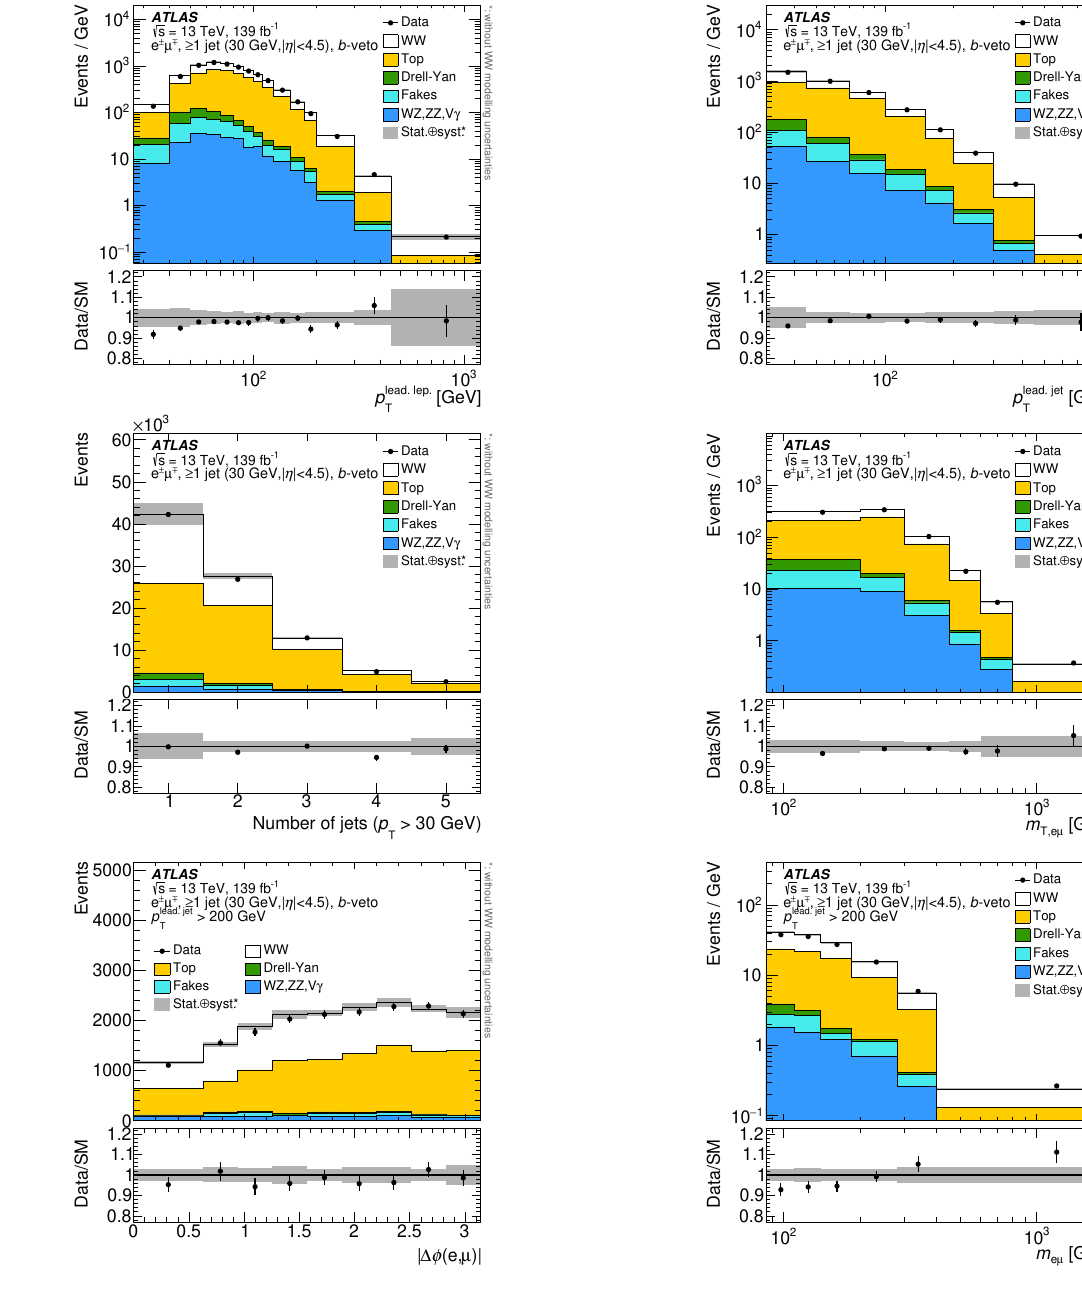
(top left), the p lead. jet (top T T (middle right), and, for events with p lead. jet > T ,eµ T (bottom right). Data are shown as black markers eµ